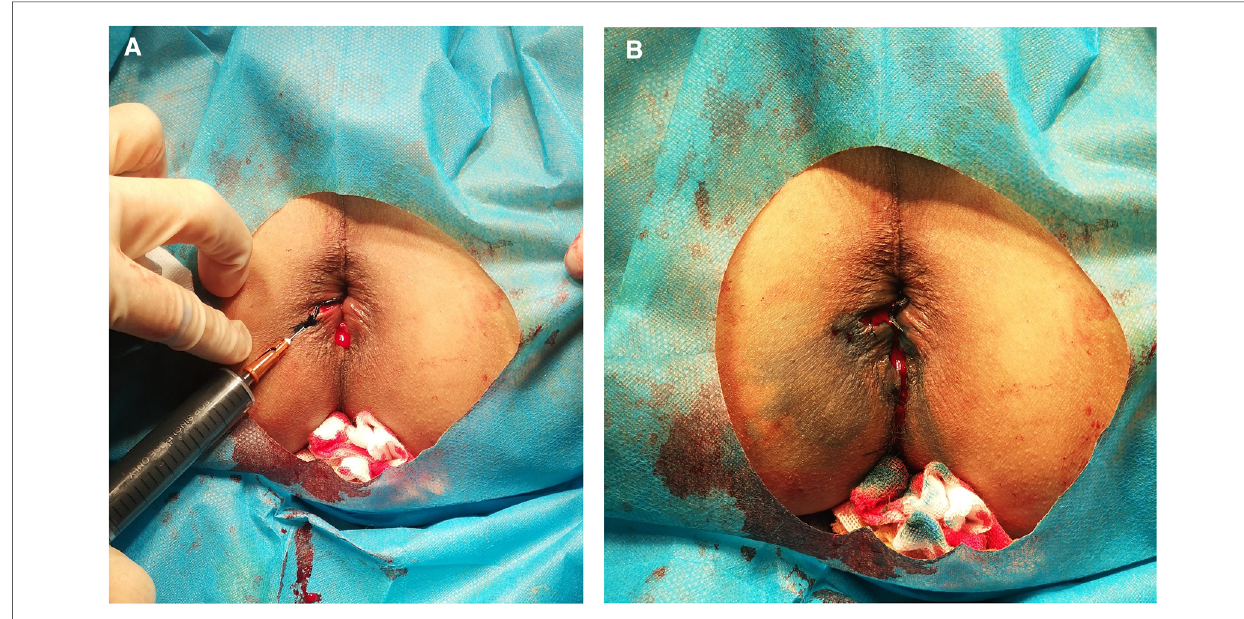
FIGURE 1 The technique of methylene blue injection. ( A ) Injecting from the distal end of the incision to the dentate line. ( B ) Incision after injection.